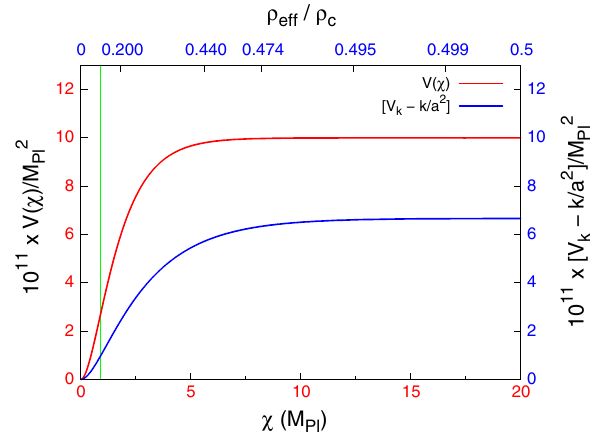
Fig. 1 The evolution of ρ eff /ρ c obtained from MG as a function of the normalized field χ . These solutions satisfy Eq. (49). Note that the black line curve does not correspond to a physically consistent solution. The vertical green line indicates the end of the inflationary epoch ( χ end (cid:3) 0 . 94 M Pl )